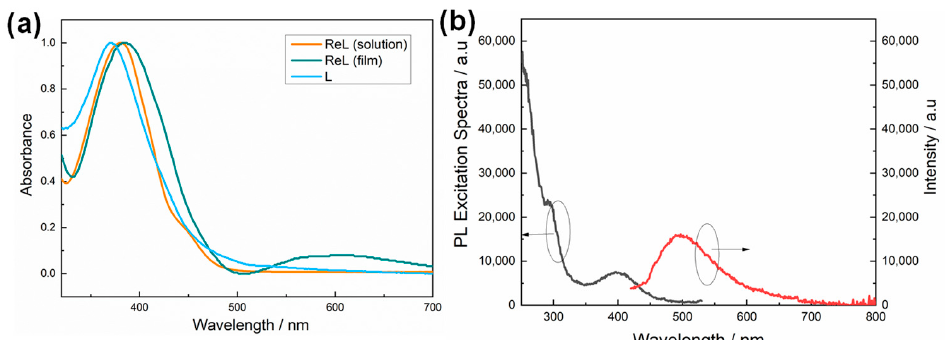
Figure 1. ( a ) Comparison of normalized UV–vis absorption spectra of ligand L (blue line) and [Re(CO) 3 Cl(L)] in drop-casted film (green line) and DCM solution (red line) at room temperature. ( b ) Excitation (black line, λ em at 500 nm) and emission (red line, λ ex at 400 nm) spectra of [Re(CO) 3 Cl(L)] in DCM solution (1.38 μ M).